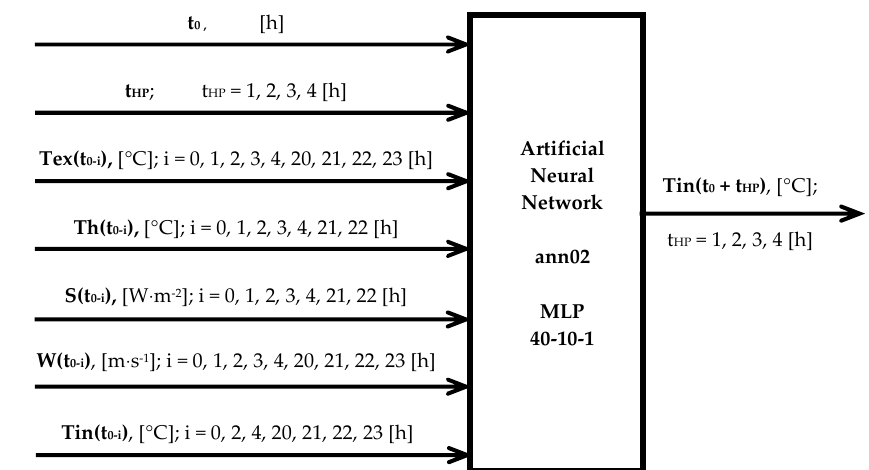
Figure 3. Structure of the ANN model.